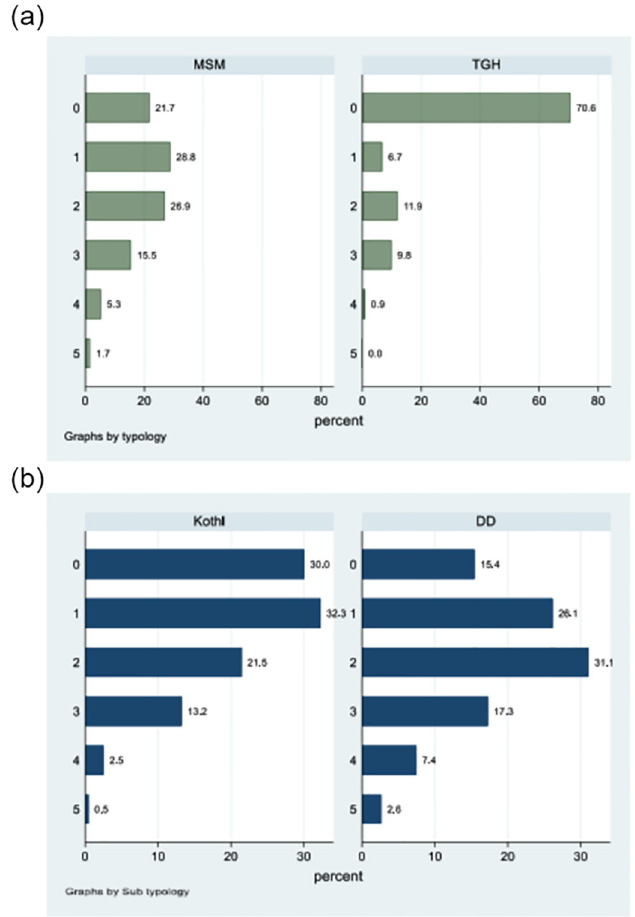
Fig 1. a. Figure showing the number of web-based/online applications by men who have sex with men and male-to- female transgendered people, Mumbai, India. b. Figure showing the number of web-based/online applications by kothis and double- deckers, 8592 men who have sex with men in Mumbai, India.